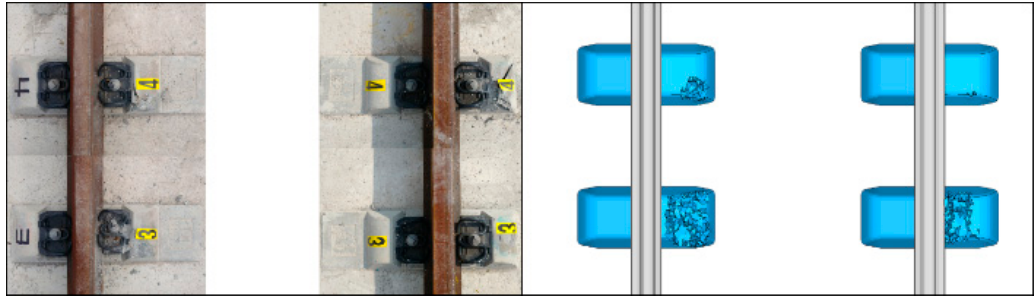
Figure 11. The broken sleepers.